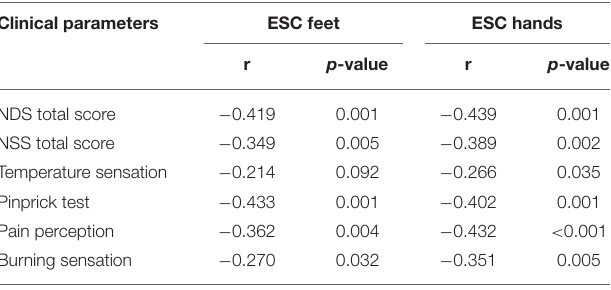
TABLE 3 | Relationship of Sudoscan measures with clinical scoring systems. Clinical